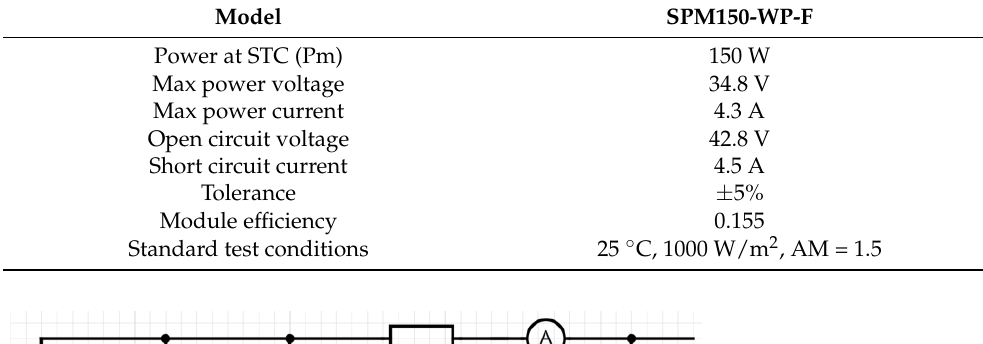
Figure 8. PV modules connection to the DC/DC converter. Table 4. Characteristics of the selected PV module.